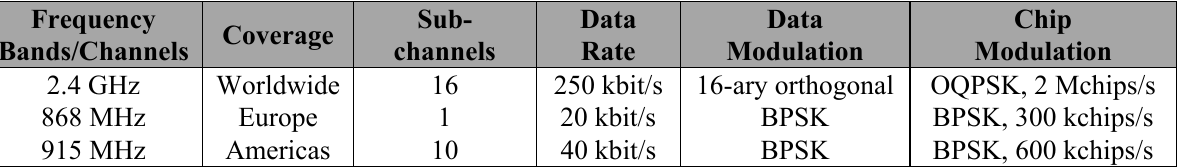
Figure 2. IEEE 802.15.4 superframe